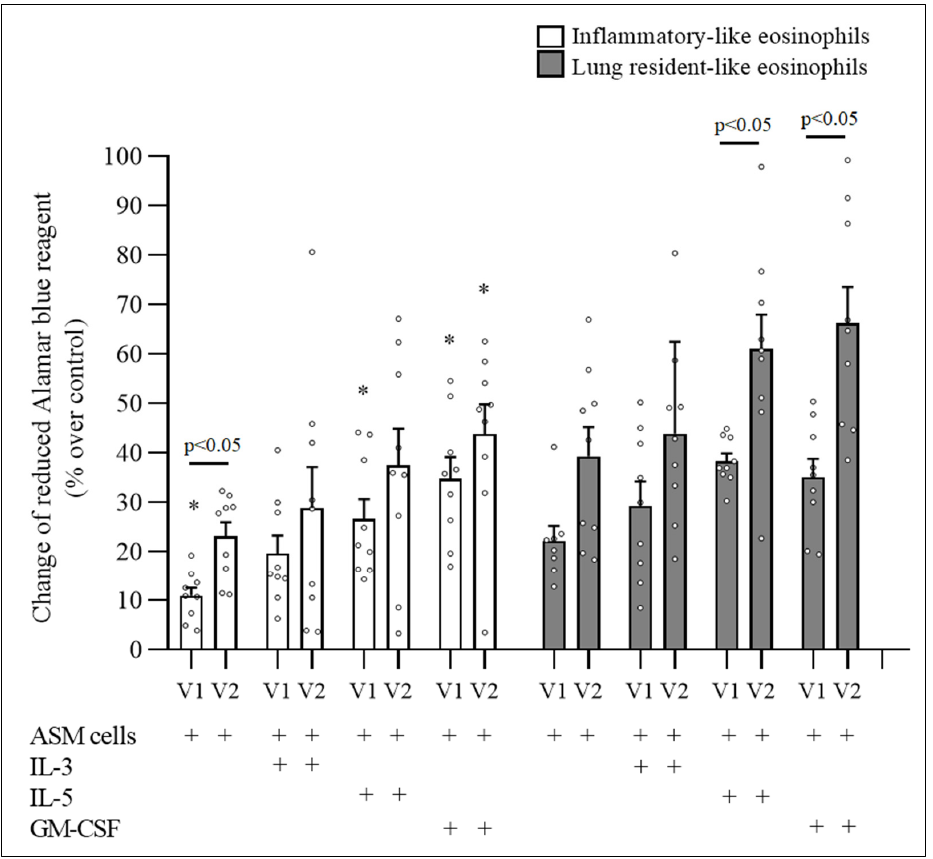
Figure 3. The effect of bronchial allergen challenge on proliferative properties of blood eosinophil subtypes in allergic asthma. ASM—airway smooth muscle; IL—interleukin; GM-CSF—granulocyte- macrophage colony-stimulating factor, V1—visit 1 (before bronchial allergen challenge); V2—visit 2 (24 h after bronchial allergen challenge). Results from independent experiments of AA, n = 8. Data presented as the mean ± standard error of the mean. * p < 0.05 compared with appropriate rEOS-like cells. Statistical analysis: between investigated groups, Mann–Whitney two-sided U-test; within one study group, Wilcoxon matched-pair signed-rank two-sided test.